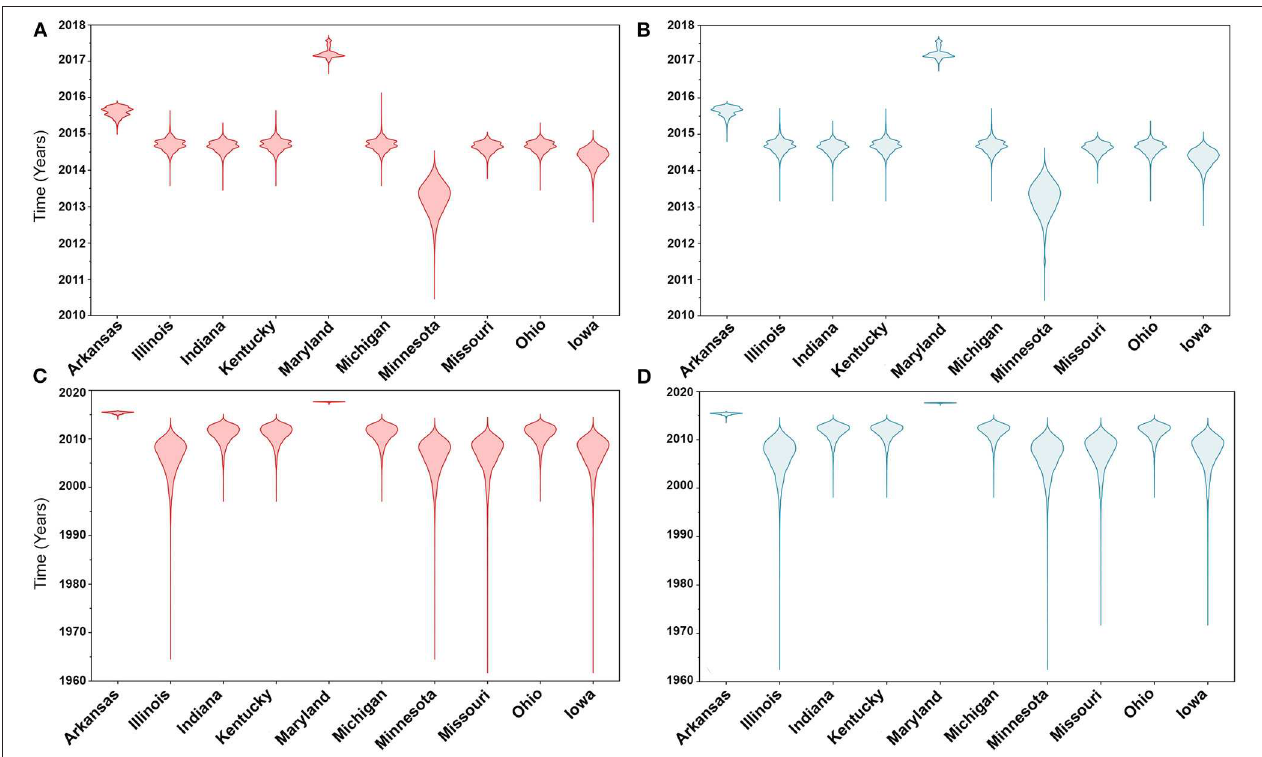
FIGURE 3 | Violin plots of state level time to the most recent common ancestors (TMRCA) of hemagglutinin (HA) and polymerase basic 2 (PB2) gene segments of human-like H3 swine influenza virus collected between January 2015 and June 2018 in the United States. The plots were generated from the Skygrid coalescent tree model. Red and blue colors indicate the asymmetric and symmetric BSSVS priors, respectively. (A) TMRCAs of HA gene estimated from the asymmetric BSSVS model; (B) TMRCAs of HA gene estimated from the symmetric BSSVS model; (C) TMRCAs of PB2 gene estimated from the asymmetric BSSVS model; (D) TMRCAs of PB2 gene estimated from the symmetric BSSVS